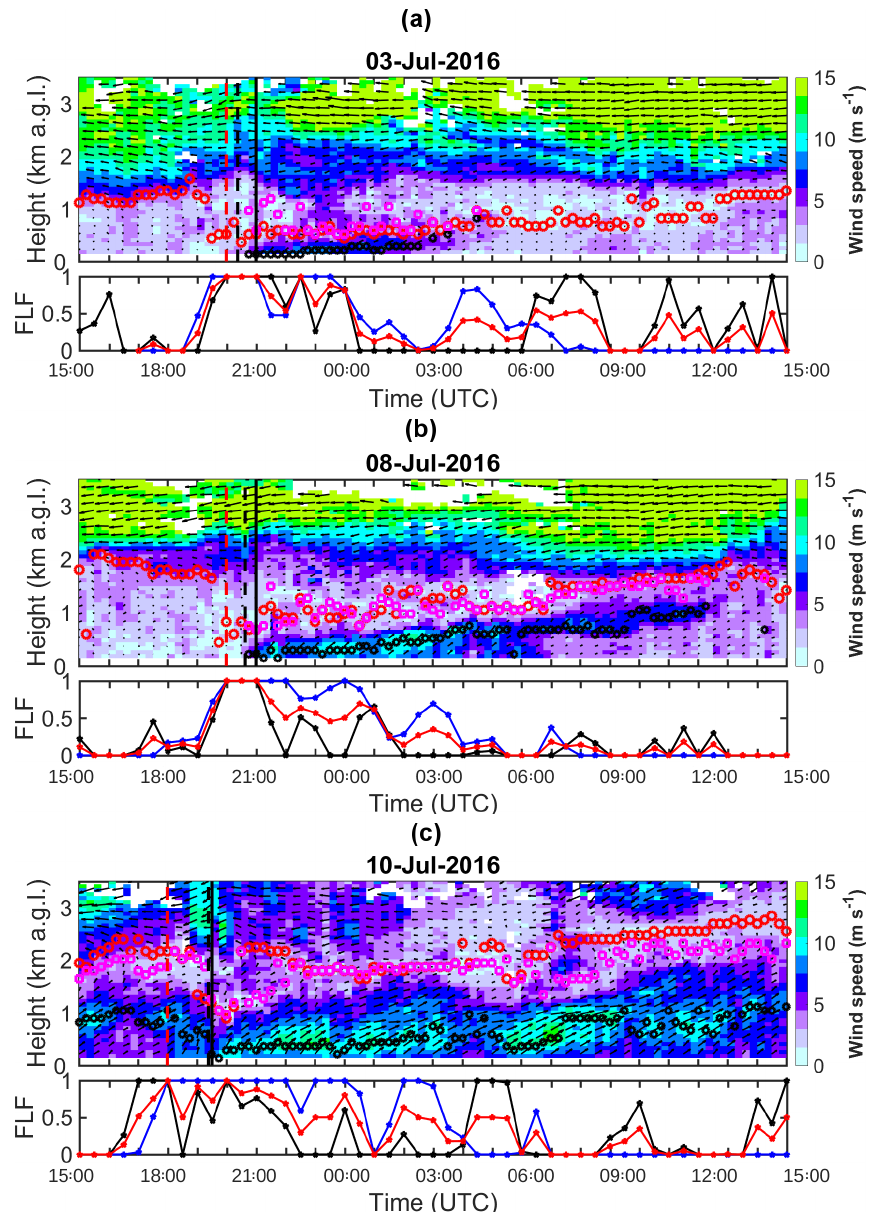
Figure 4. Time–height sections of (color) wind speed and (arrows) direction from the UHF wind profiler on the nights of (a) 2–3 July, (b) 7– 8 July, and (c) 9–10 July 2016. A leftward horizontal arrow indicates an easterly wind; an arrow from bottom to top indicates a southerly wind. The black open circles indicate the jet core height detected with a maximum wind speed of at least 5ms − 1 , the magenta rectangles indicate the height of the minimum wind speed above the jet core, and red open circles indicate the monsoon flow depth. The black, blue, and red lines in the lower box indicate the three fuzzy logic functions of the wind speed, temperature, and their mean, respectively. The red and black dashed vertical lines indicate the MI arrival time estimated using two different criteria: (1) the FLF mean > 1 criterion and (2) the 302K isentrope criterion, respectively. The black vertical line indicates the NLLJ